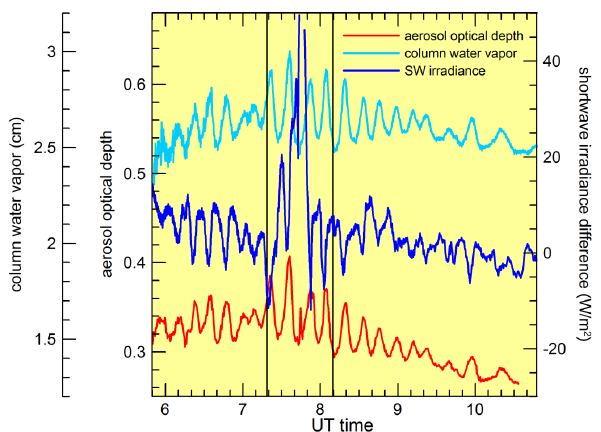
Fig. 2. Evolution of aerosol optical depth at 500 nm, column water vapour, and of the difference between the measured downward shortwave irradiance and the irradiance estimated at fixed aerosol optical depth and column water vapour (see text) during the morning of September 5, 2007. The region between the two vertical lines corresponds to the presence of thin clouds in the sky imager pictures.